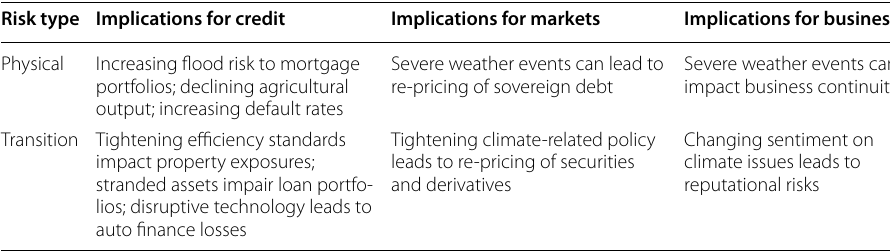
Source: Bank of England